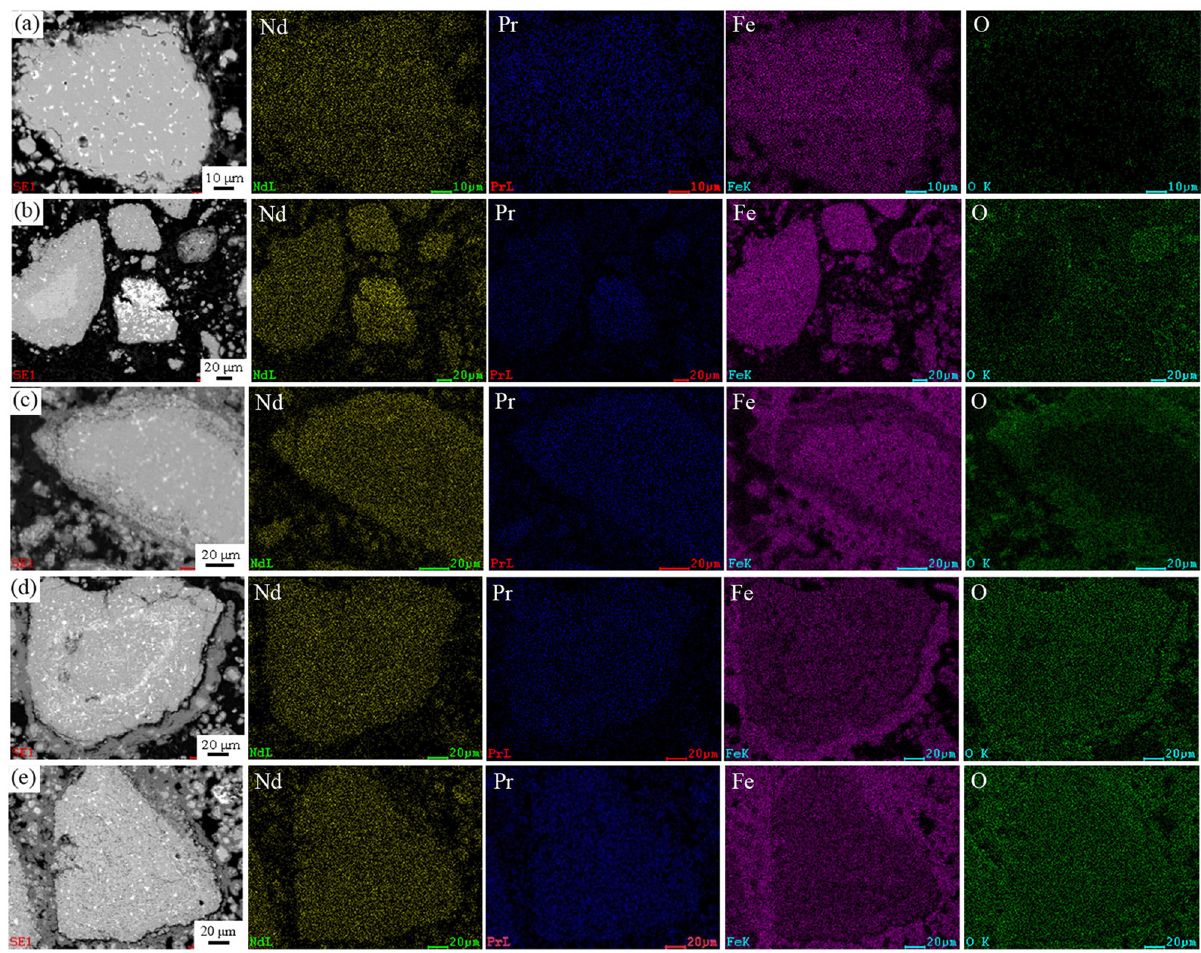
Figure 7: The mapping distribution of elements for the Nd – Fe – B magnet scrap powder oxidized at 800°C with di ff erent roasting cycles. ( a ) Unroasted Nd – Fe – B scrap powder; ( b ) fi rst cycle of roasting; ( c ) second cycle of roasting; ( d ) third cycle of roasting; ( e ) fourth cycle of